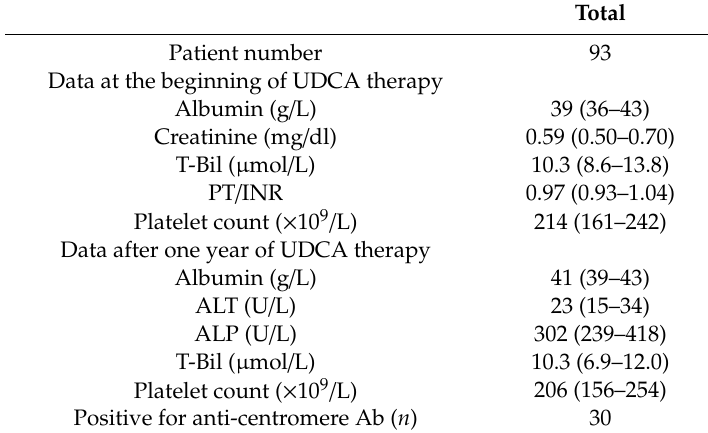
Table 2. Patient characteristics of those with available blood exams data after one year of UDCA therapy.